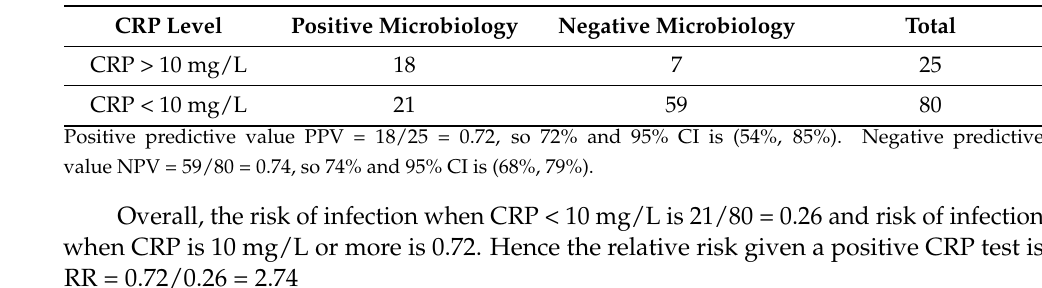
Table 3. Confusion matrix for C-reactive protein (CRP) prediction of